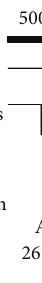
Figure 3: Illustrative map of miR-375 promoter region. Vertical lines depict the CpG dinucleotides. The arrow indicates the transcriptional start site. Gray filled box is CpG island and black filled bars are MassARRAY studied amplicon regions. Amplicon characteristics are shown beneath the black bars and bp indicates base pair.